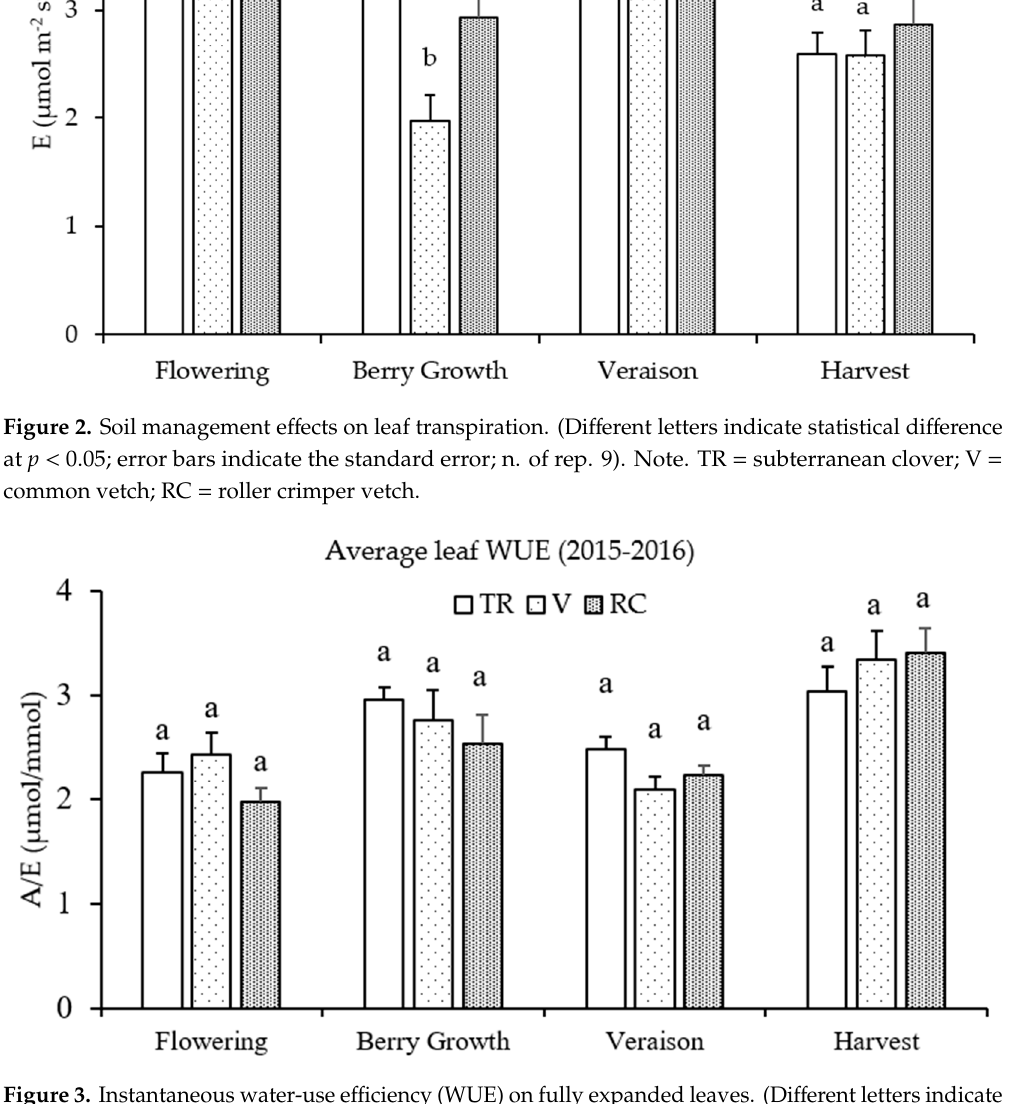
Figure 3. Instantaneous water-use efficiency (WUE) on fully expanded leaves. (Different letters indicate statistical difference at p < 0.05; error bars indicate the standard error; n. of rep. 9). Note. TR = subterranean clover; V = common vetch; RC = roller crimper vetch.